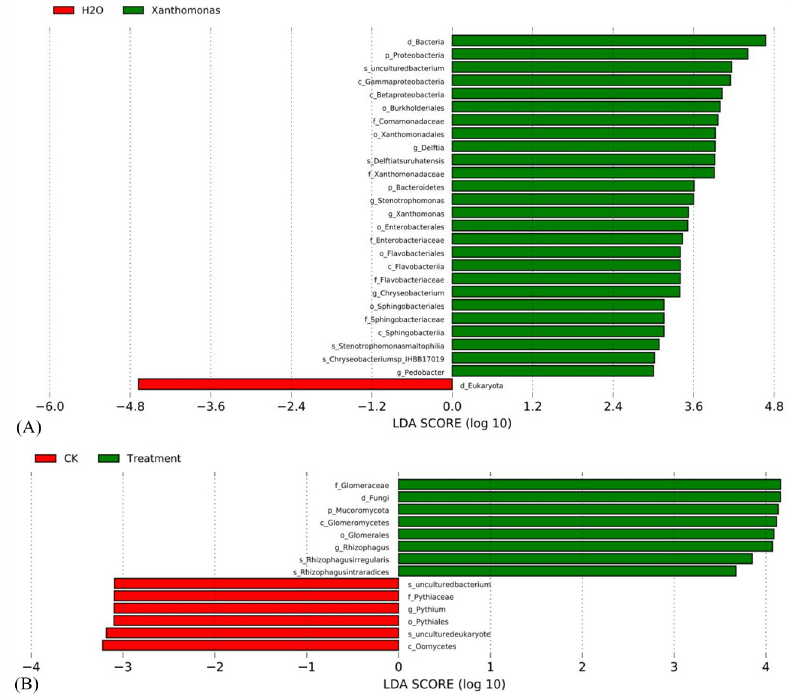
Figure 9. Biomarkers with a significant difference. Note: ( A ) Common soybean inoculation with X. phaseoli . H 2 O, the control sample of common bean; Xanthomonas , the common bean sample inoculated with X. phaseoli pv. phaseoli strain CFBP6546R. As the inoculum, Xanthomonadales at the order level, Xanthomonadaceae at the family level, Xanthomonas at the genus level can be seen as biomarkers after inoculation with X. phaseoli . ( B ) Maize roots inoculation with AM fungus. CK, the control sample of maize; Treatment, the maize roots inoculated with R. irregularis DAOM-197198. As the inoculum, Rhizophagus at the genus level, Rhizophagus irregularis at the species level can be seen as biomarkers after inoculation with R. irregularis DAOM-197198.